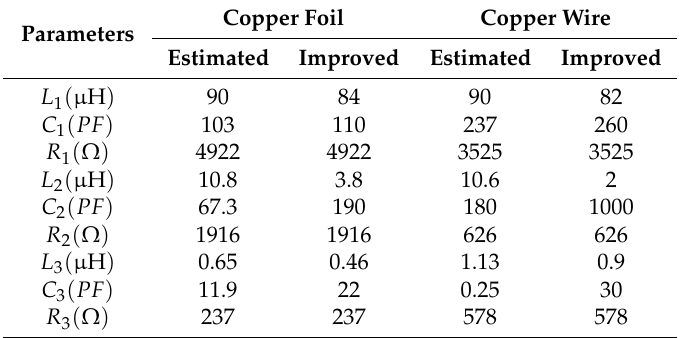
Table 4. Equivalent circuit parameters in the copper foil inductor and the copper wire inductor. Copper Parameters